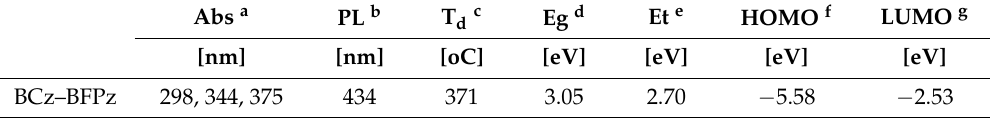
Figure 2. ( a ) UV-visible and fluorescence (FL) spectra of BCz–BFPz in toluene (10 − 5 mol L − 1 ) and phosphorescence spectrum of BCz–BFPz in 2-methylfuran solvent at 77 K; ( b ) FL spectra of BCz–BFPz in different solvents (10 − 5 mol L − 1 ). Table 1. Photophysical, thermal properties, and HOMO/LUMO energy levels of BCz–BFPz. Abs a PL